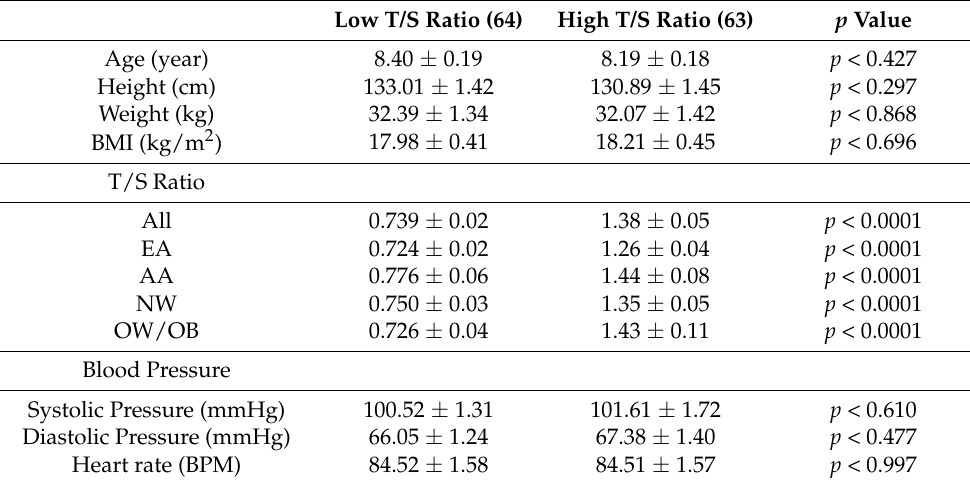
Table 1. General characteristics of the study population.